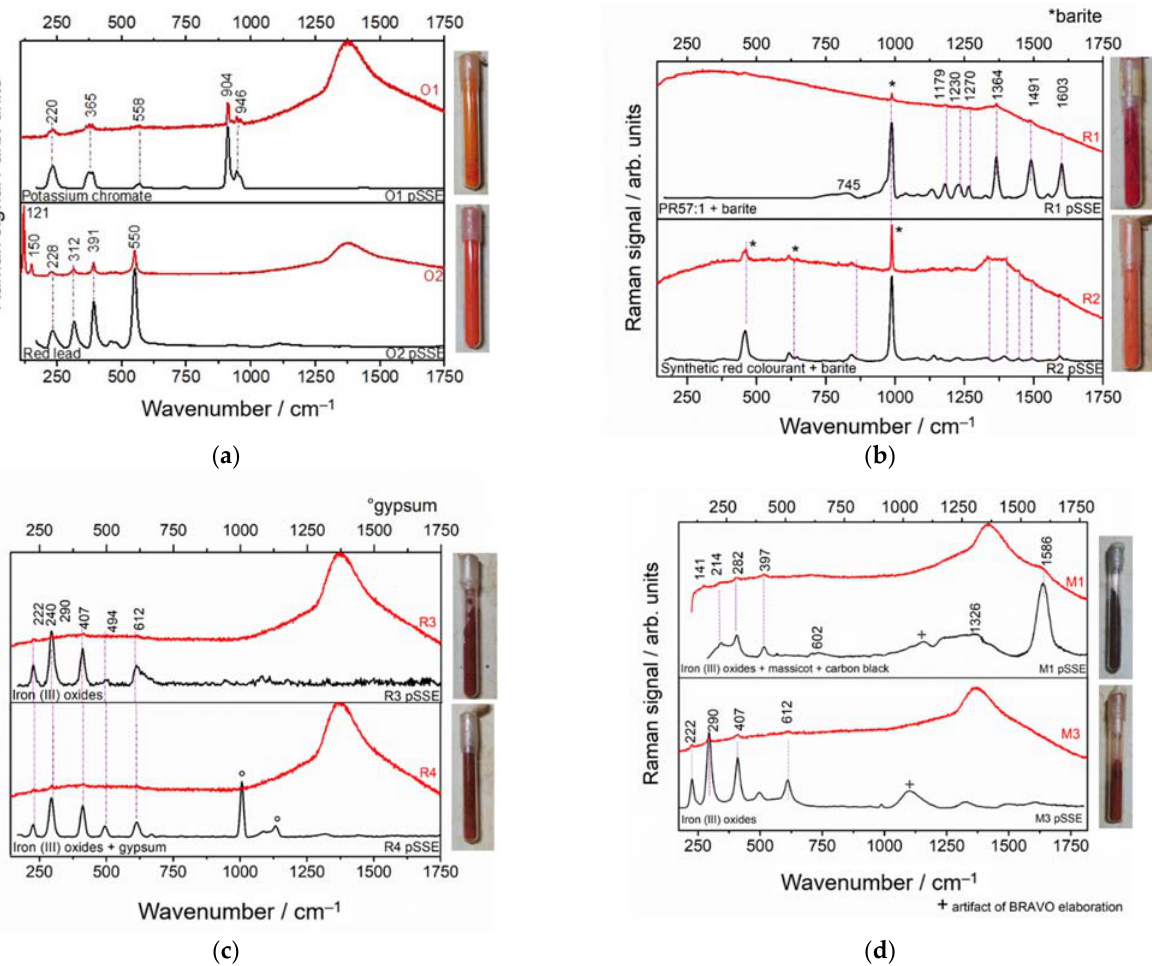
Figure 7. pSSE (black line) and dispersive (red line) RS of examined ( a ) orange (top ‐ to ‐ bottom: potassium chromate, red lead); ( b ) red (top ‐ to ‐ bottom: PR57:1, synthetic red colorant + barite), ( c ) red (top ‐ to ‐ bottom: iron(III) oxides, iron(III) oxides + gypsum); ( d ) brown (top ‐ to ‐ bottom: iron(III) oxides + carbon black, iron(III) oxides) materials. The considered spectral range is 170–1750 cm − 1 .